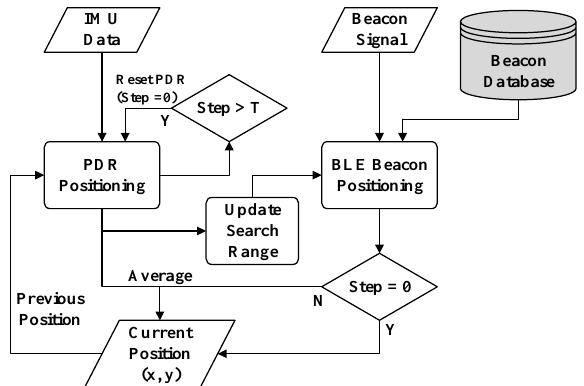
Figure 8. Flow chart of hybrid positioning application (App. 1) using BLE beacon and